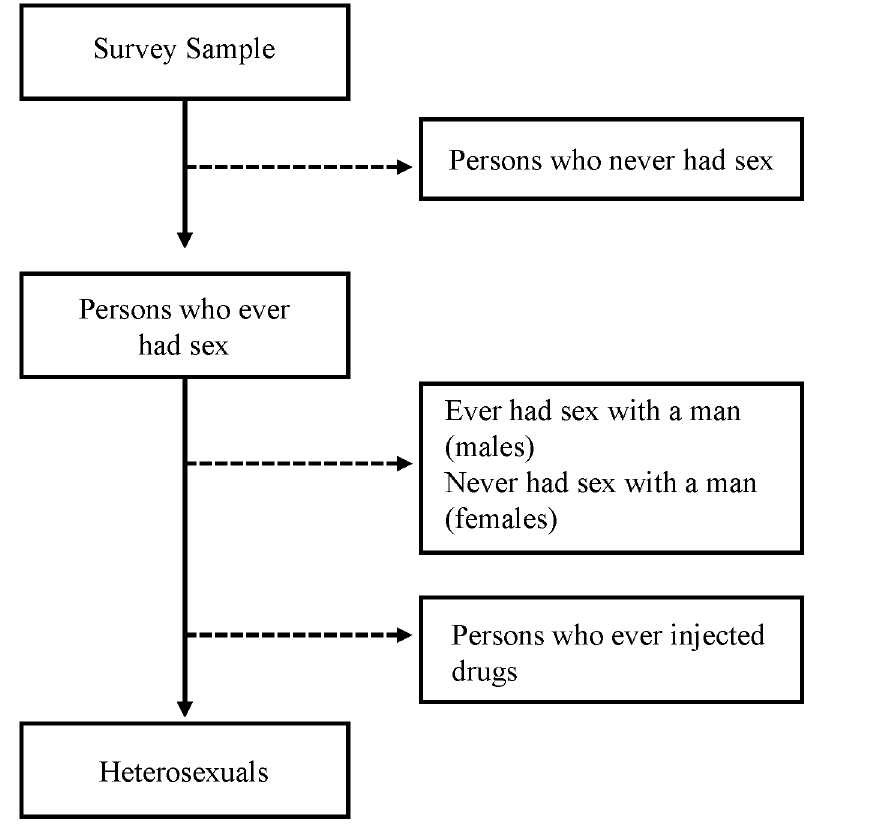
Fig 1. Definition of Heterosexual for